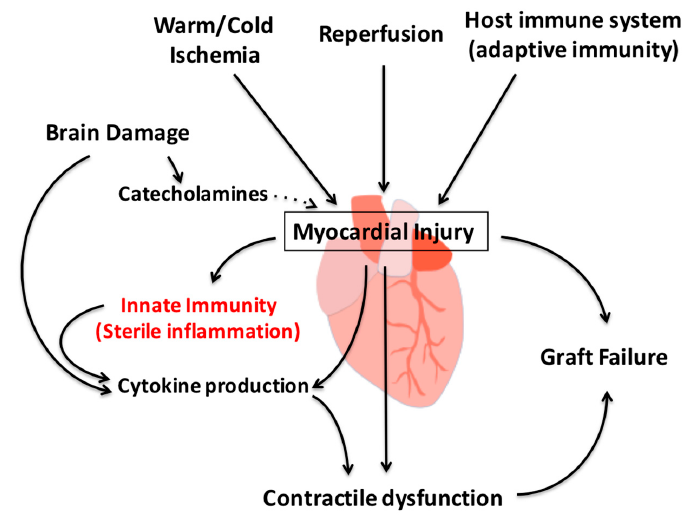
Figure 7. Myocardial injury triggers activation of the innate immunity. Ischemia, reperfusion injury and the host immune system induce injury to the heart, amplification of the inflammatory response, and production of pro-inflammatory cytokines. This phenomenon leads to further injury and contractile dysfunction, ultimately leading to graft failure.